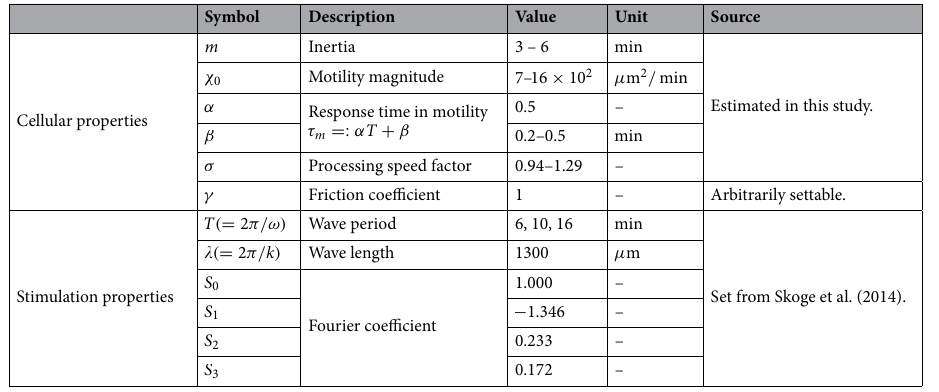
Table 1. Parameter values used or estimated in this